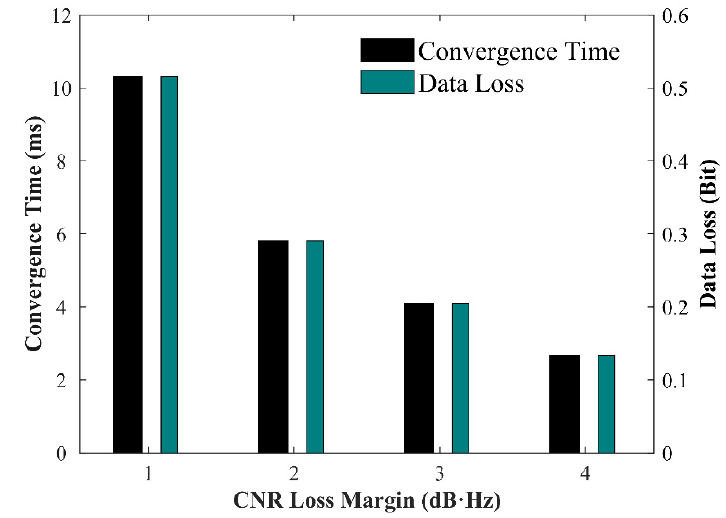
Figure 6. The effect of CNR loss margin on convergence.